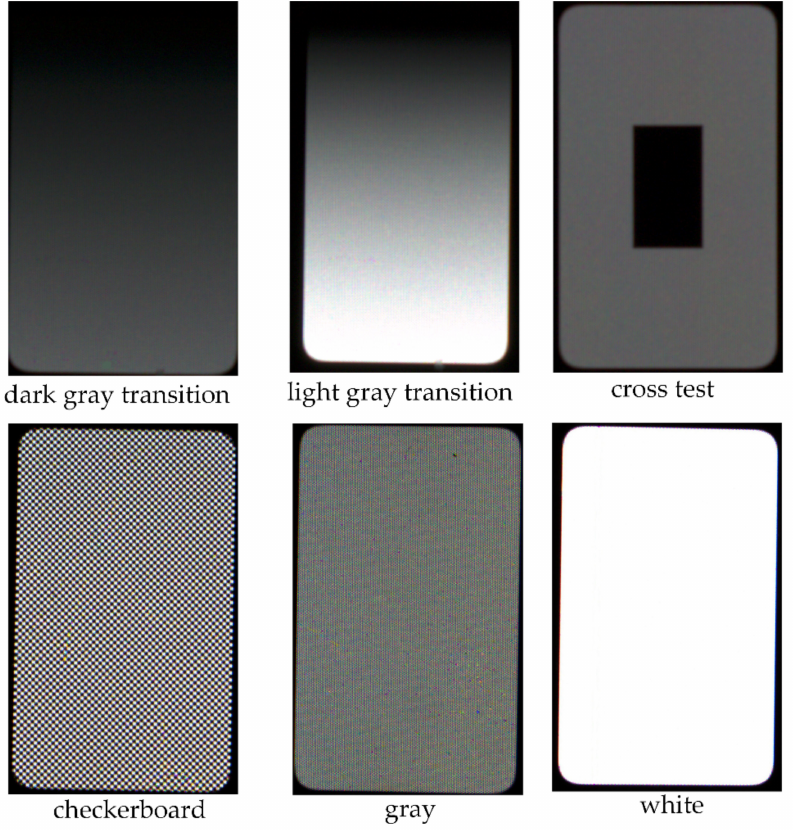
Figure 3. Typical Display